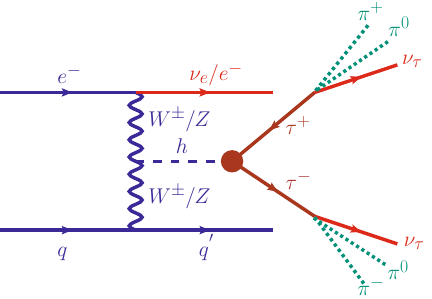
Fig. 1 Leading order Feynman diagram for h production via the charged/neutral current process in e − p collider. The figure shows the process e − p → ν e / e − h j , h → τ + τ − with τ ± → π ± π 0 ν τ , q are the partons from proton and q (cid:7) is the scattered